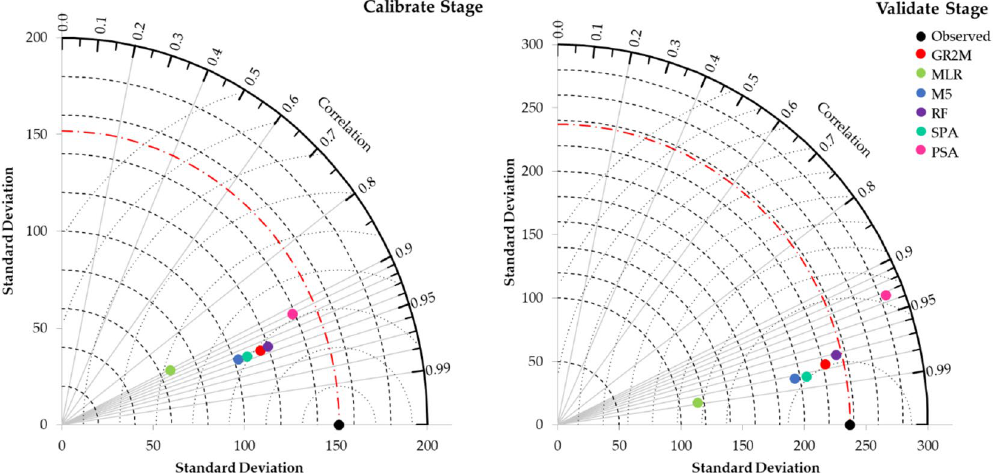
Figure 9. Taylor diagram for the regionalized GR2M model for training and testing